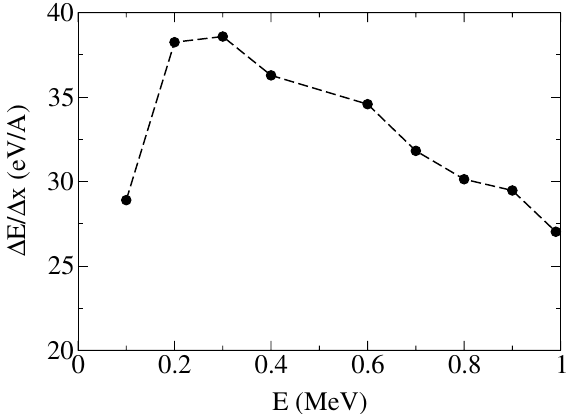
Figure 1. Linear energy transfer of a pencil beam of proton as a function of proton kinetic energy in water.